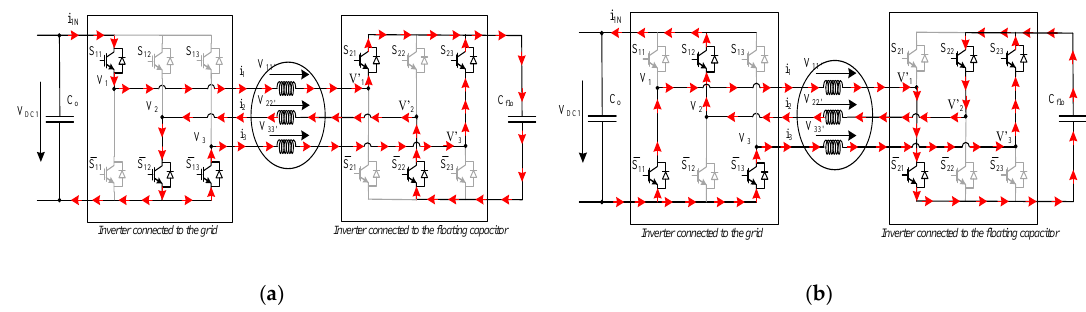
Figure 6. Condition of the switches and direction of the currents for sector I ( a ) floating capacitor in charging mode by the application of vector 38 and ( b ) floating capacitor in charging mode by the application of vector 20.